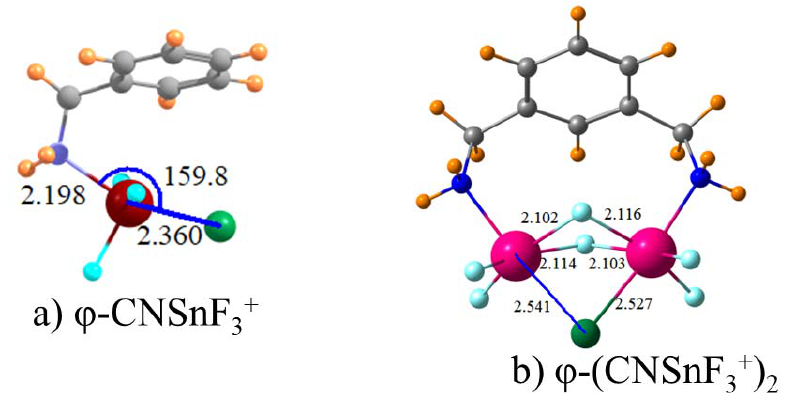
Figure 3. Geometries of indicated Lewis acids with Cl − . Distances in Å, angles in degs.